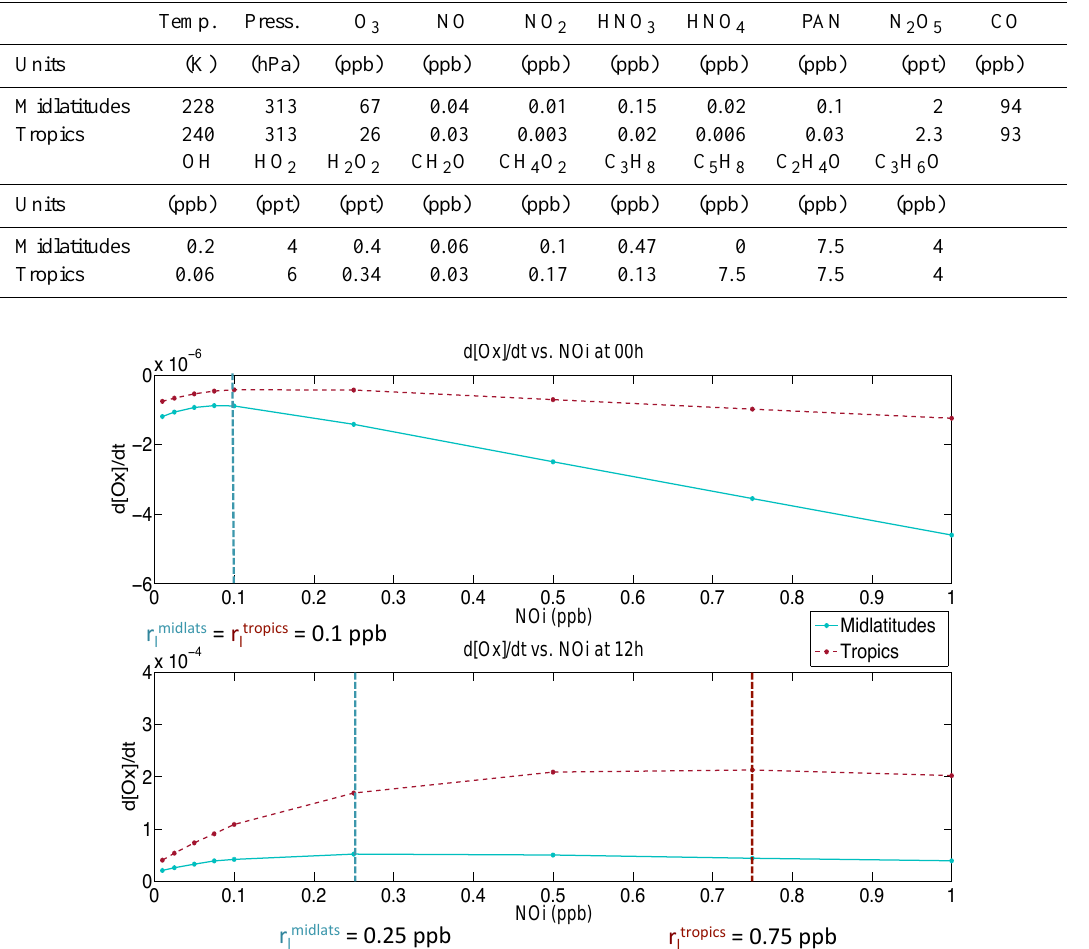
Figure 2. r l critical value and odd oxygen trends from DSMACC box model simulations for midlatitudes (solid line) and tropics (dotted line) at midnight (upper panel) and at midday (bottom